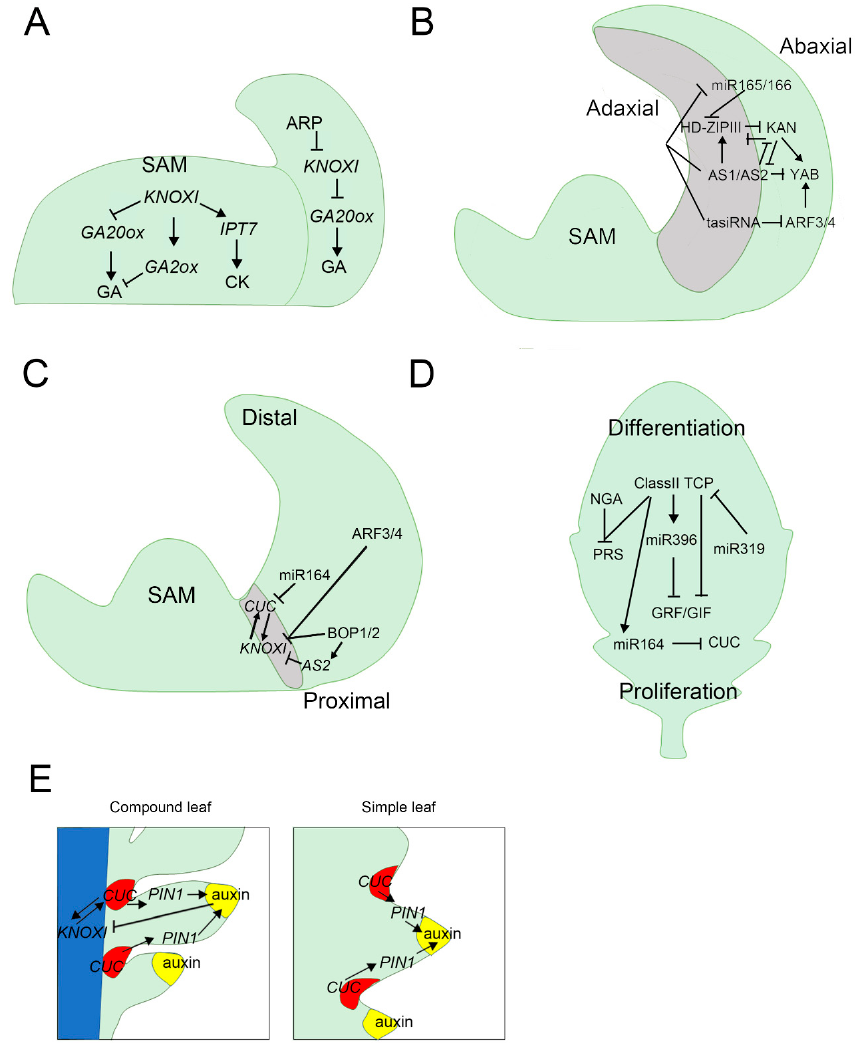
Figure 3. Genetic and hormonal factors that control leaf development. ( A ) Genetic and hormonal factors are controlling primordium development. Class-I KNOTTED-LIKE HOMEOBOX (KNOXI) proteins maintain high cytokinin (CK) levels and low GA levels in the shoot apical meristem (SAM). ARP maintains high GA level through repression of KNOXI. ( B ) Adaxial-abaxial polarity establishment in a developing leaf. HD-ZIPIII functions antagonistically to KANADI (KAN) and YABBY ( YAB ) acts downstream of KAN on the abaxial side. miR165/166 represses HD-ZIPIII, but ASYMMETRIC LEAVES 1 (AS1) and AS2 promote the expression of HD-ZIPIII on the adaxial side and repress miR165/166, KAN , and YAB . ta-siRNAs target miR165/166 and Auxin response factor 3/4 (ARF3/4) to restrict them to the abaxial side. ( C ) Proximal-distal polarity establishment in a developing leaf. KNOXI genes are expressed in the boundary region, and CUP-SHAPED COTYLEDONS (CUCs) have positive feedbacks with KNOXI. Blade on PETIOLE 1 (BOP1) and BOP2 are expressed in the proximal region to repress KNOXI directly, or indirectly by AS2. ARF3/4 also repress KNOXI to promote organogenesis at the shoot apex. ( D ) The switch from cell proliferation to differentiation follows a process that is promoted by the miR319- TCP module and repressed by the miR396-GRF module. PRESSED FLOWER ( PRS ) is also repressed by class II TCP and NGATHA (NGA), promoting cell proliferation in the leaf margin. ( E ) Common molecular pathways underpin both simple and compound leaf formation. PIN-FORMED 1 (PIN1) localization at the developing leaf is polar so that an auxin activity maximum is formed at the tip of both serration and leaflet. KNOXI are expressed in the rachis of the compound leaf, where they activate CUC expression at the distal boundary of the leaflet and promote polar localization of PIN1 in the leaflets. In turn, CUC activity maintains KNOXI expression in the rachis while auxin downregulates KNOXI expression for leaflet formation. CUC expression and auxin maxima promote the development of serrations. Yellow represents an auxin activity maximum, red the domain of CUC expression, and the blue color denotes the expression domain of KNOXI . Panel A, C, and D is based on [121] and B is based on [122]. Panel E is based on